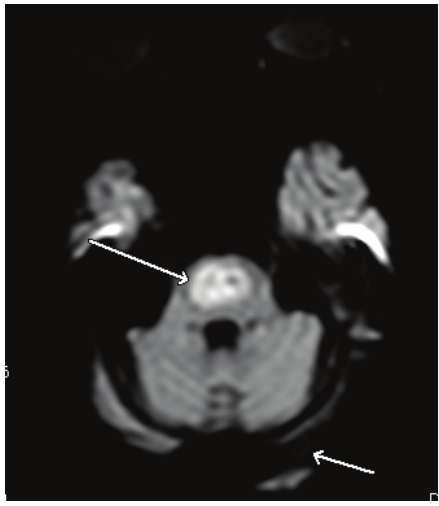
Figure 3: Diffusion weighted MRI image of our patient demonstrat- ing central pontine